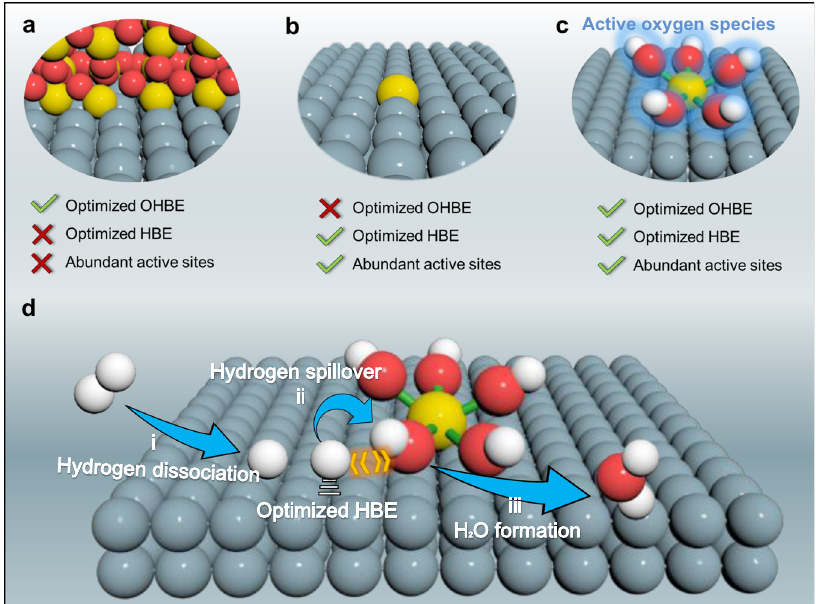
Fig.1|SchemeillustrationoftheproposedcatalystdesignstrategyforHOR. Typicallyreported heterostructure( a )andsingle-atomalloy( b )catalystsforHOR. c The structure of Ru – Cr 1 (OH) x catalyst. d Proposed HOR mechanism for Ru – Cr 1 (OH) x catalyst. Color: Gray, Ru; yellow, Cr; red, O; white,